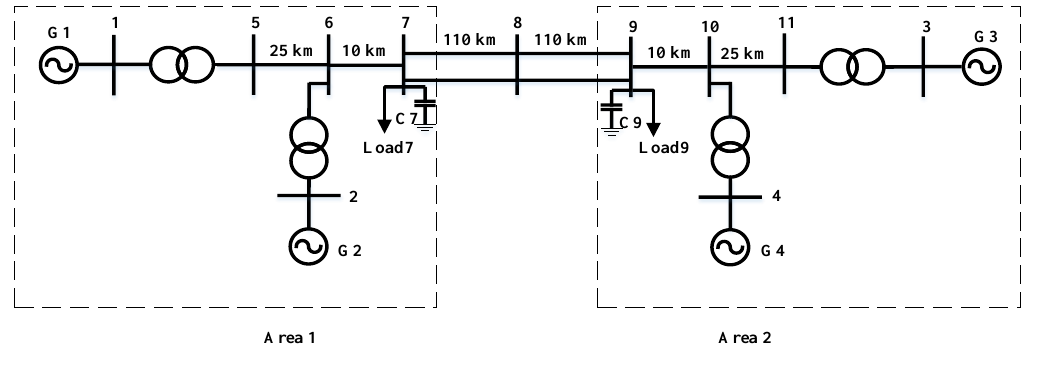
Figure 5. Four-machine two-area test system.